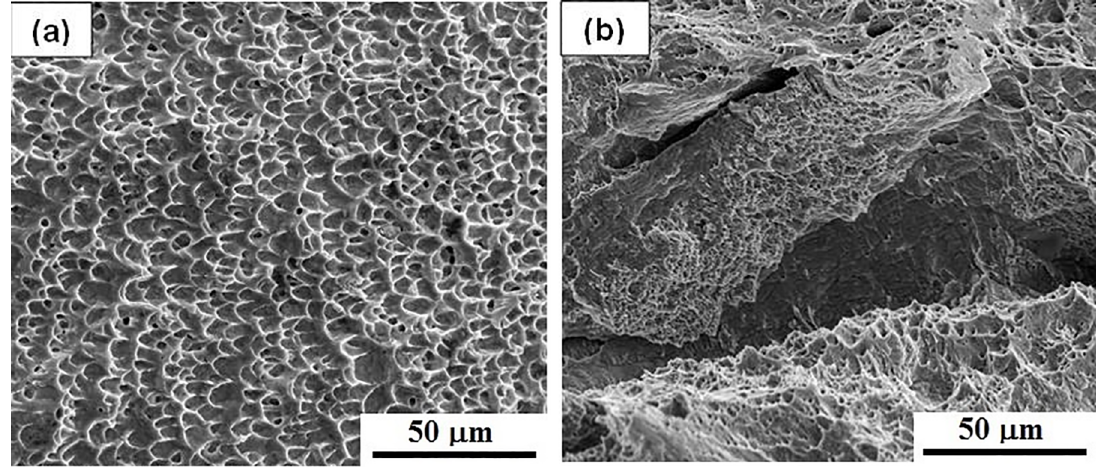
Figure 9. Surface of weld metal fracture as welded. (a) GTAW, (b) FSW.